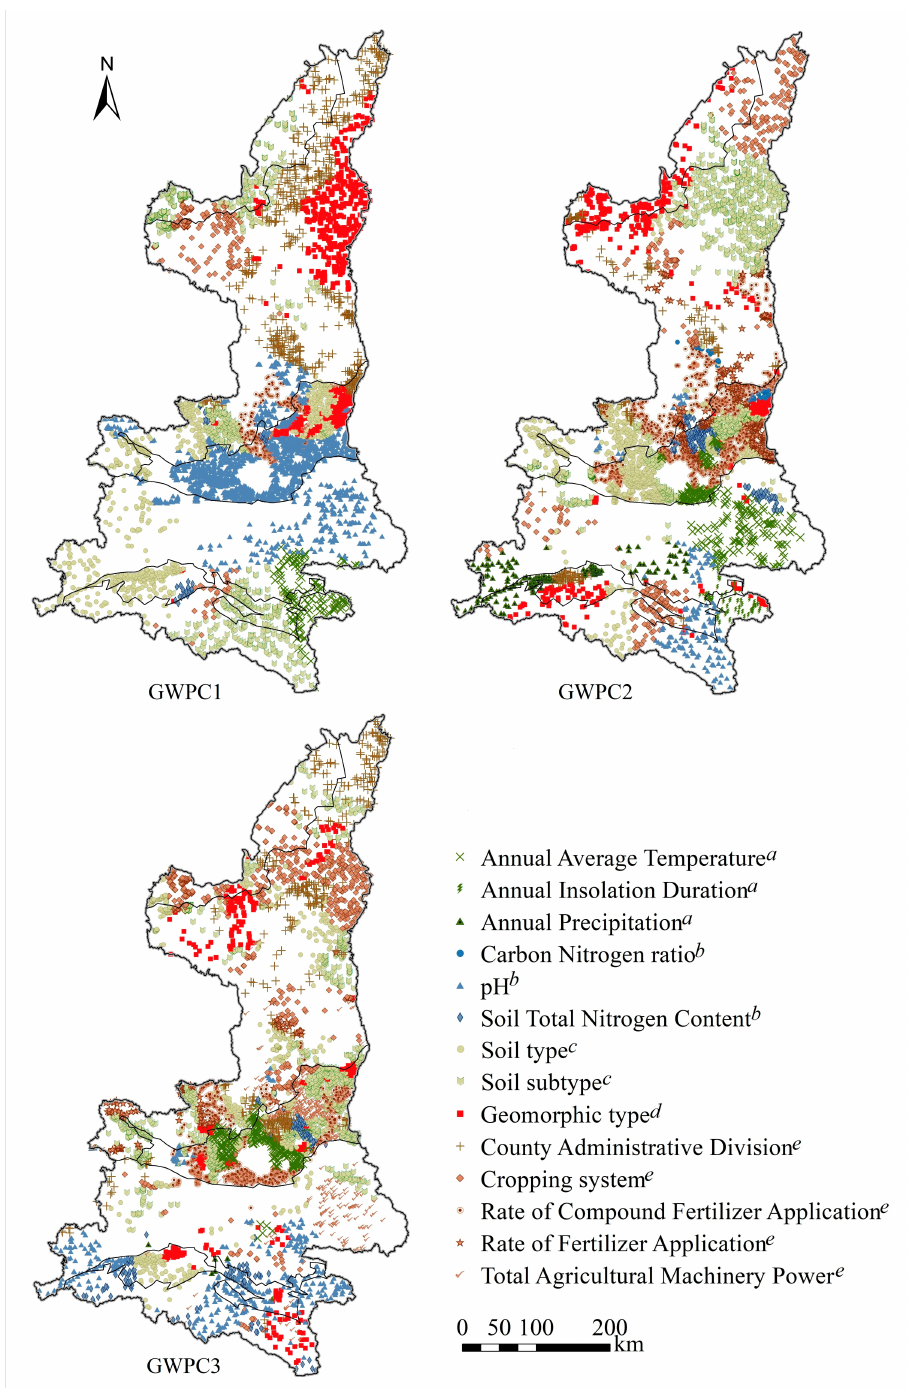
Figure 4. Maps of the winning variables (i.e., the variables with the highest loadings) in GWPC1, GWPC2, and GWPC3. a , Climate Factors; b , Soil Nutrient Factors; c , Soil Type Factors; d , Geomorphic Type Factors; e , Human